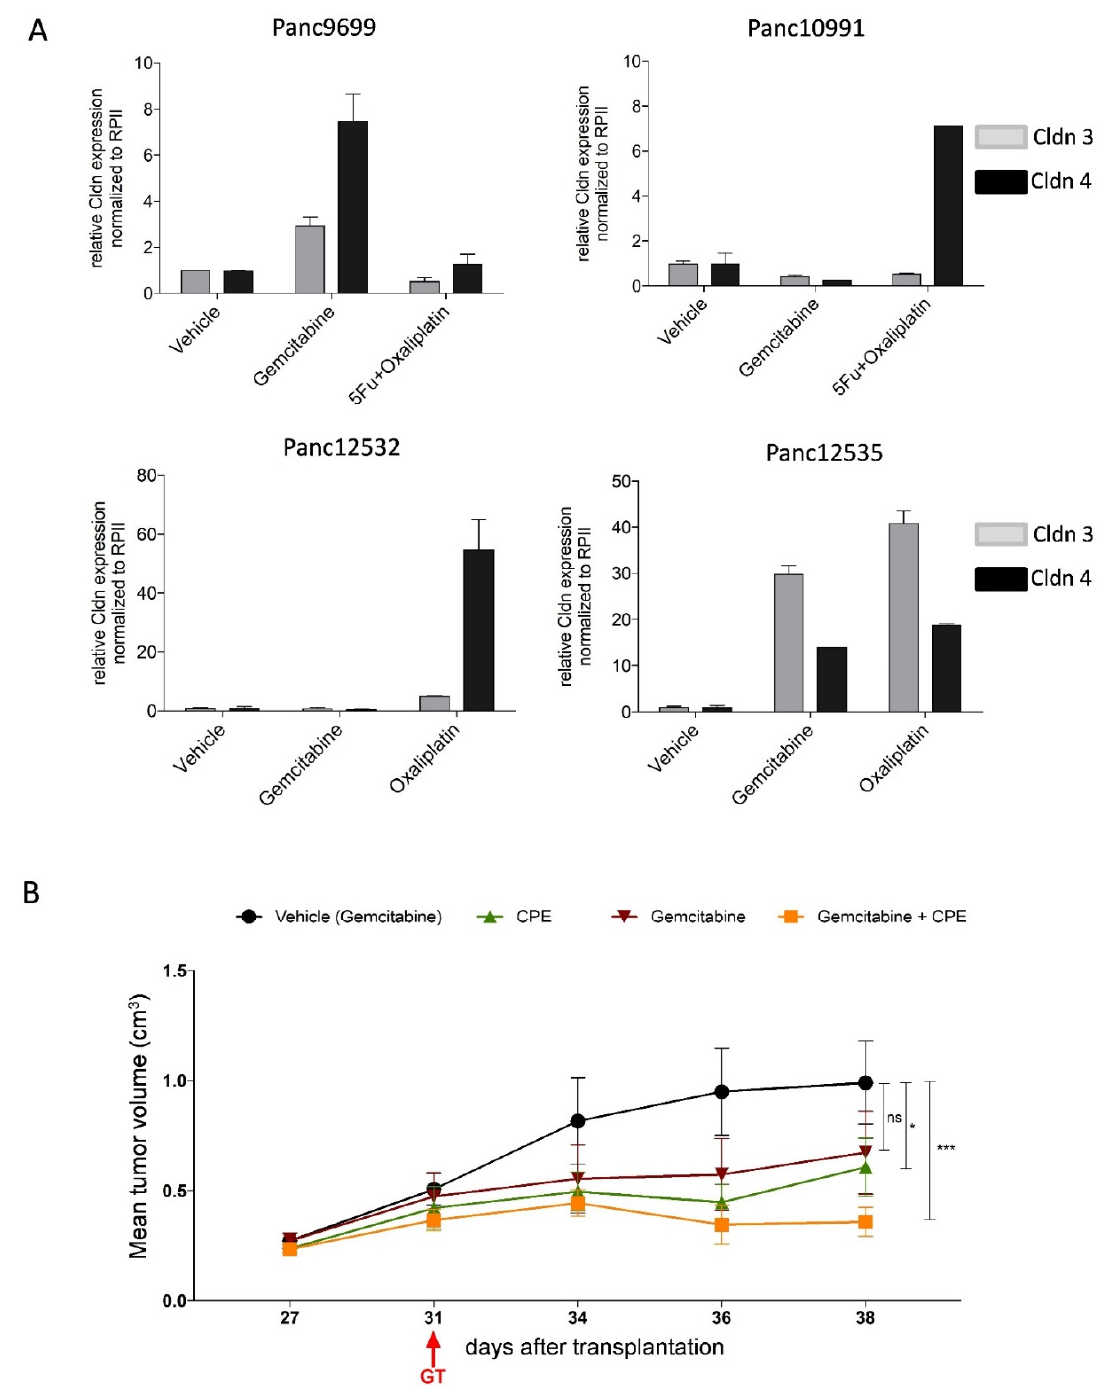
Figure 8. Novel combination of optCPE gene transfer and standard of care drugs. ( A ) Drug treatment induces Cldn3/4 expression in PC PDX, determined in four PDX by qRT-PCR. Gemcitabine treatment increased expression of both Cldns in Panc9699 and Panc12535. Treatment with oxaliplatin or oxaliplatin + 5-FU induces claudin expression in Panc10991 and Panc12532 tumors. Data are represented as means ± S.D. ( n = 2). ( B ) Synergistic antitumoral effect of combined optCPE gene therapy and gemcitabine treatment in Panc12535 bearing mice. Gemcitabine was applied intraperitoneally at day 27 and four days later optCPE gene transfer (GT) was performed (31 days after tumor transplantation). The in vivo optCPE gene transfer (green) significantly inhibited tumor growth. This was further improved by combination with gemcitabine (yellow) compared to gemcitabine monotherapy (red) or respective vehicle control (black). (ns: not significant; * p < 0.05; *** p <